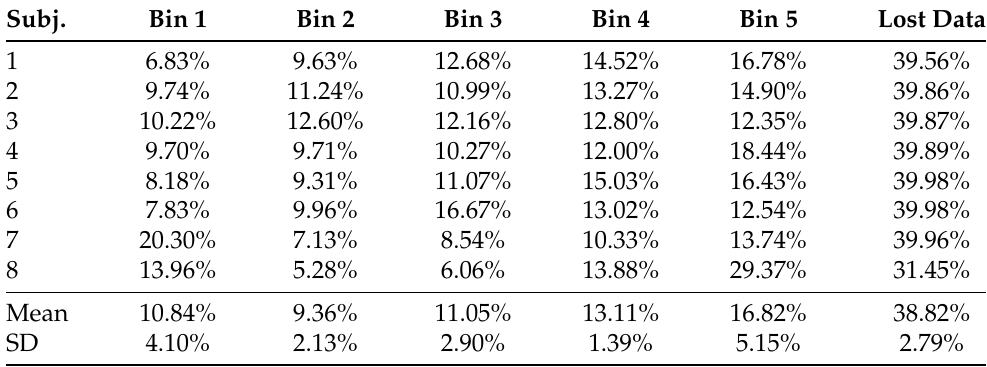
Table 6. Gating statistics in the PET images with respiratory motion-compensated reconstruction based on the RPM respiratory signal, compared to a non-gated reconstruction (100%). Subj.